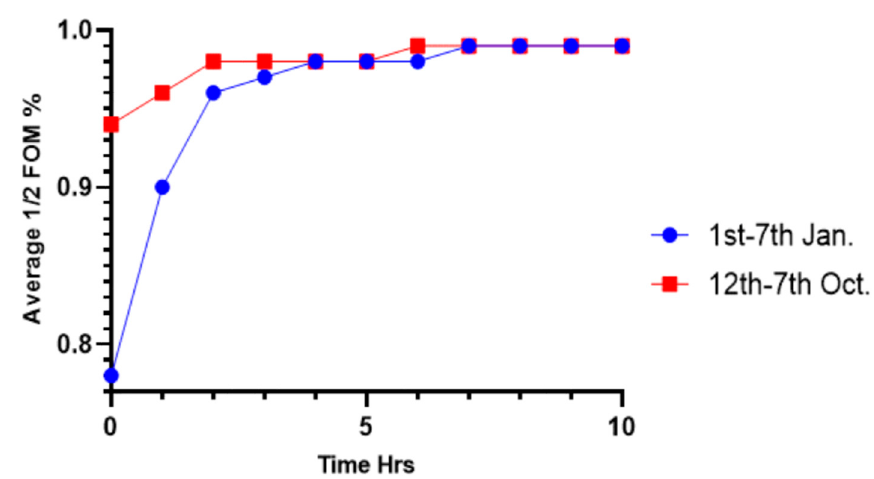
Figure 9. Average cumulative charge with month. The result, as shown in Figure 10, reveals that ½ FOM increased as the charging process was initiated as suggested in past literature [12,15,22], and it assumed a steady value (near 1) moments into the charging process. This scenario occurs due to the decrease in the thermocline thickness as the thermocline position C moves upwards towards the top of the stratified TES tank where there is less mixing of cold and warm regions of fluids. Figure 11 reveals that the average half FOM as evaluated